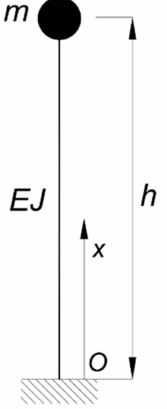
Figure 9. Single degree of freedom system (SDOF).